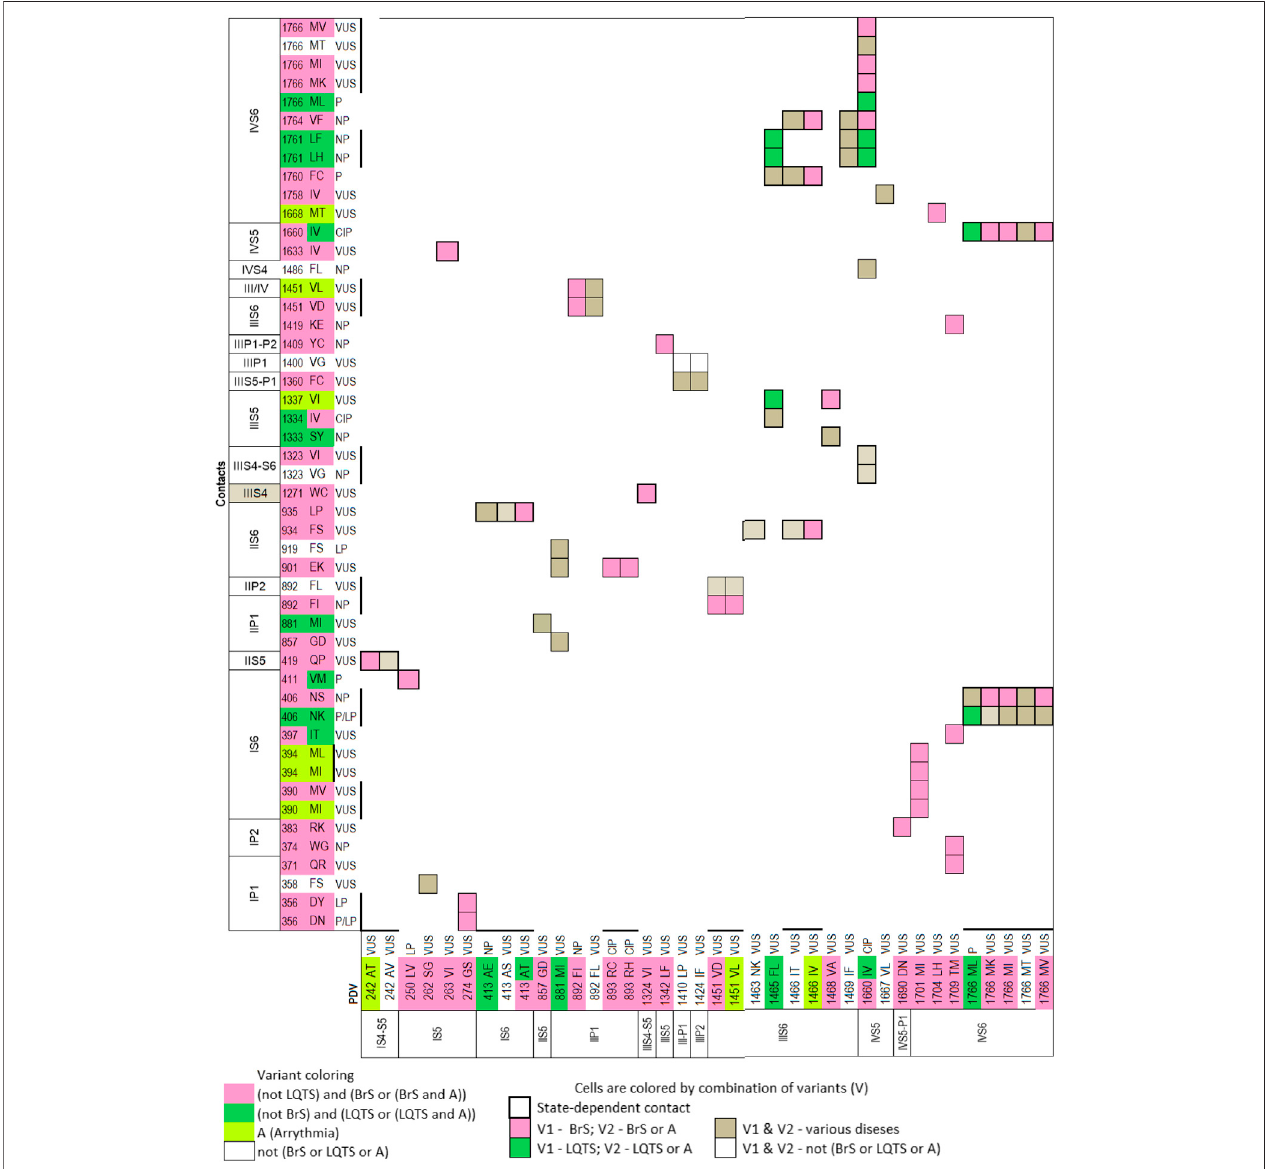
FIGURE1| MatrixofcontactvariantsinthePDcryo-EM. Bottomrows(X1-X4)representw54residuesandtheirPDVs.X1andX2showPDsegmentsandUniProt residue numbers. X3 shows one-letter codes of WT residues and their variants. X4 indicates clinical signi fi cance of variants. Variants associated with BrS1, LQT3, non- speci fi edArrhythmiasorotherdiseasesarecolored,respectively,pink,green,yellow,ornotcolored.IfbesidesBrS1orLQT3,avariantisassociatedwithanon-speci fi ed arrhythmia,itiscoloredpinkorgreen,respectively.Ifvariousdiseasesarereportedforavariant,twocolorsareused.Leftcolumns(Y1-Y4)showanalogousfeatures ofcontactvariantsofw54residues.AcoloredcellinthematrixbodylinksaPDVanditscontactvariant.IfaWTresiduehas m PDVsand n contactsvariants,aclusterof m x n colored cells shows all variant combinations. If PDV and its contact variant have the same color, it is applied to the cell. If a cell links pink and yellow variants, it is colored pink. If a cell links green and yellow variants, it is colored green. If a variant has color A and its contact variants colors A and B, color A is applied to the cell. Otherwise the cell is grey. If a residue is located in cytoplasmic halves of S6 helices, which move upon the channel gating, respective cell is bold-boxed.